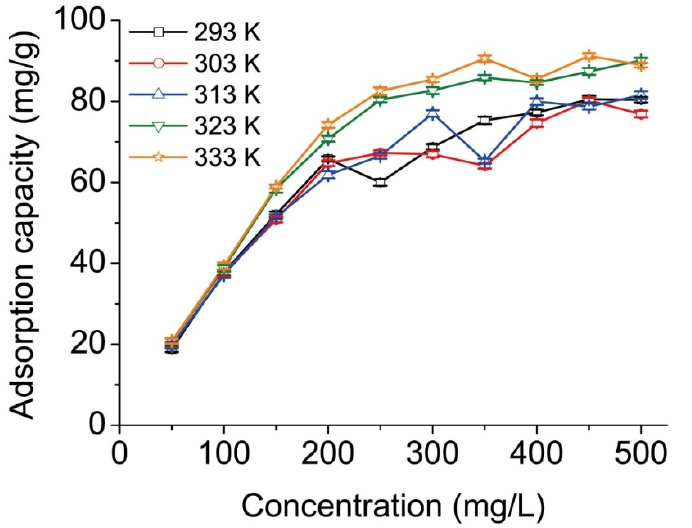
Figure 4. Adsorption isotherms of methyl orange onto